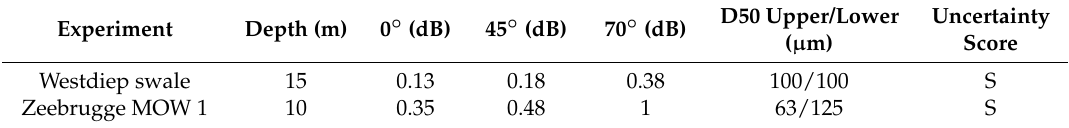
Table 8. Table reporting the estimated uncertainty introduced by the suspended sediment absorption coefficient ( α s sensu [43,65]) for the 2nd and 3rd experiments and for nadir (0 ◦ ), oblique (45 ◦ ) and grazing (70 ◦ ) angles. Out of the four and two profiles for the 2nd and 3rd experiments respectively, only the worse-case scenarios are